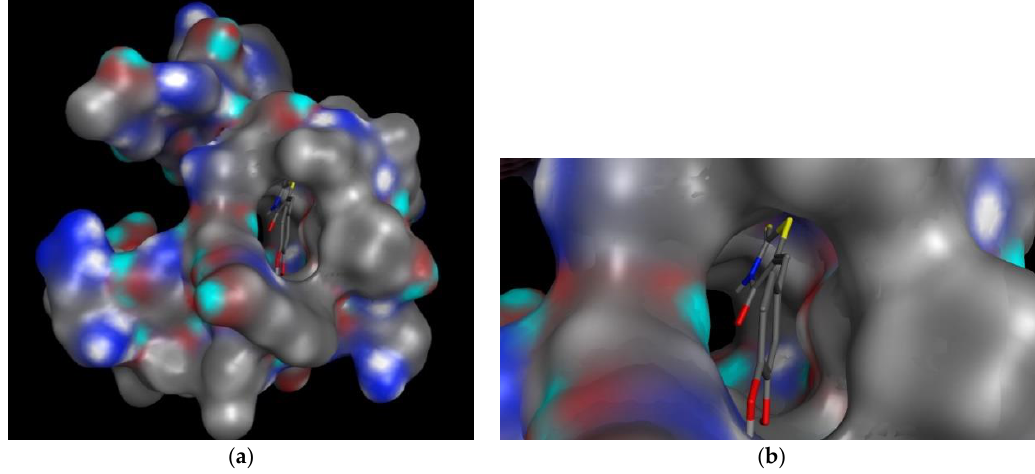
Figure 4. Surface representation of: ( a ) The entire tyrosine kinase hematopoietic cell kinase (Hck); and ( b ) a segment of tyrosine kinase Hck active site with docked compound 2e .